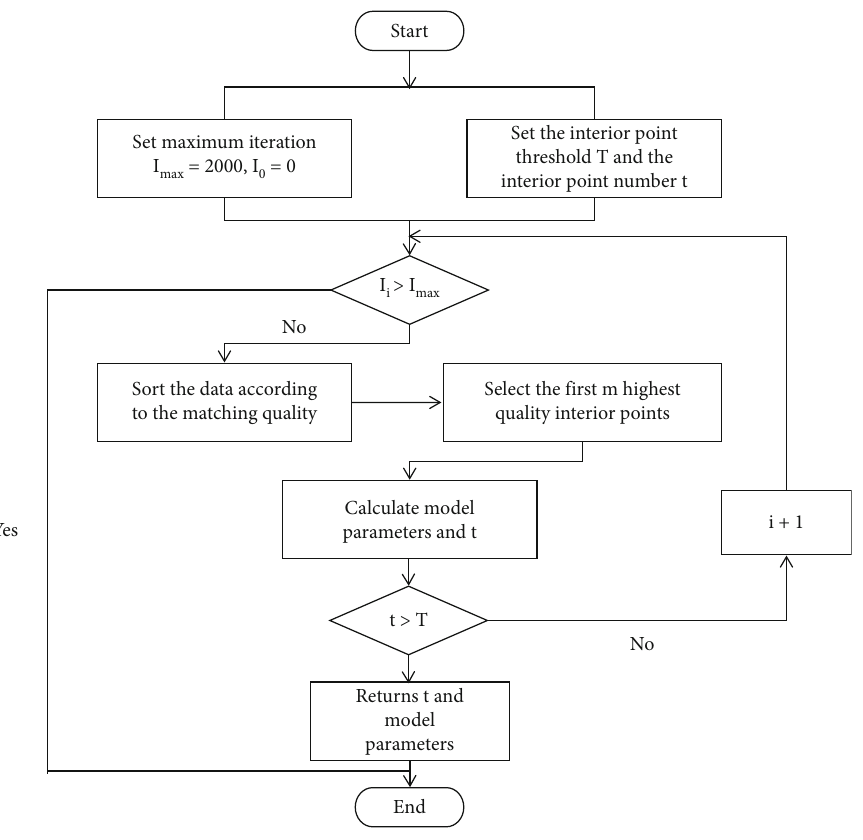
Figure 6: PROSAC algorithm fl ow PROSAC algorithm can e ffi ciently eliminate mismatched high-precision matching interior points. In image matching,